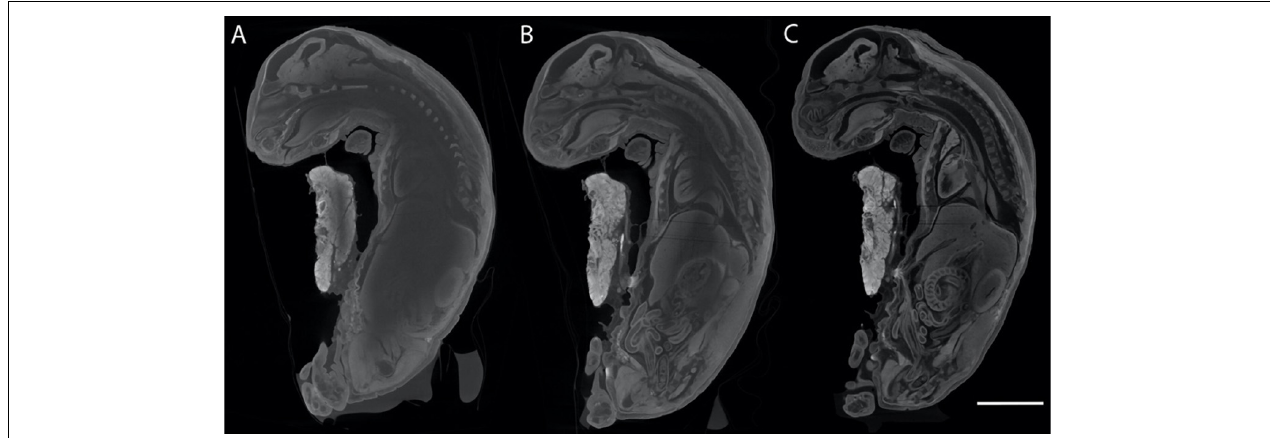
FIGURE 3 | Sagittal µ CT slices taken from generally the same area of the same O. cuniculus specimen (Racicot and Ruf, 2020), stained for different lengths of time to show increasing contrast imparted by the Lugol’s iodine stain. (A) Stain penetration after 5 weeks and 2 days, (B) penetration after 7 weeks, (C) stain penetration after 11 weeks and 2 days. Scale bar of 10 mm applies to all